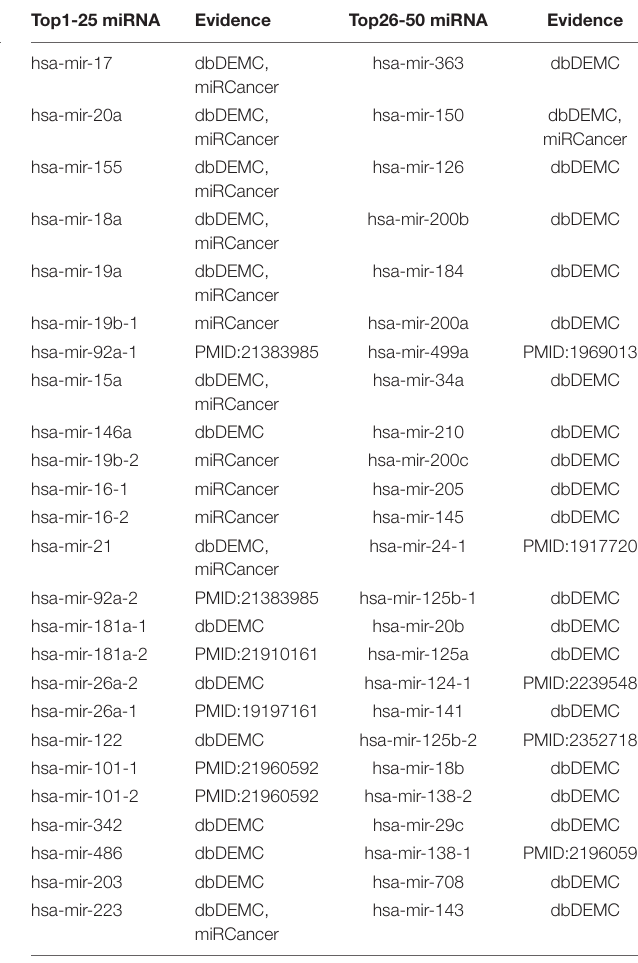
TABLE 6 | Top 50 Related miRNAs of Lymphoma predicted by MDN-NMTF on HMDD2.0-Yan Dataset. Top1-25 miRNA Evidence Evidence